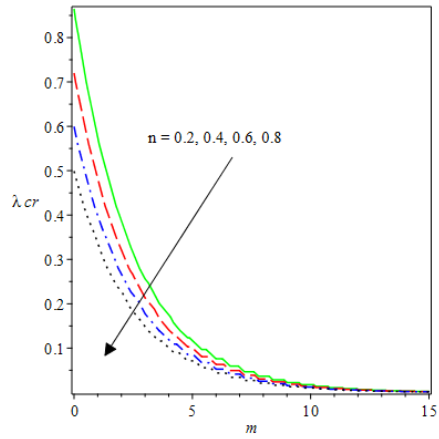
Figure 19. Plot of λ cr against m for ( n )